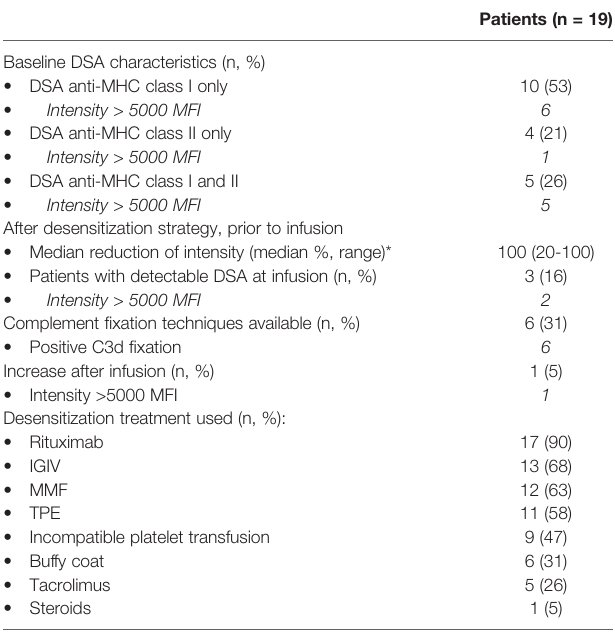
TABLE 2 | Donor speci fi c antibodies: characteristics, kinetics and management.